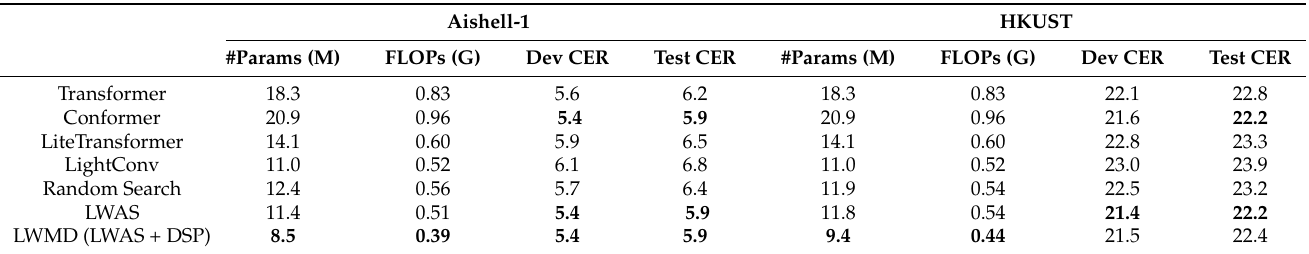
Table 1. Experiment results under the CTC framework. FLOPs refer the averages of processing one-second speech. The best results on each framework are in boldface.